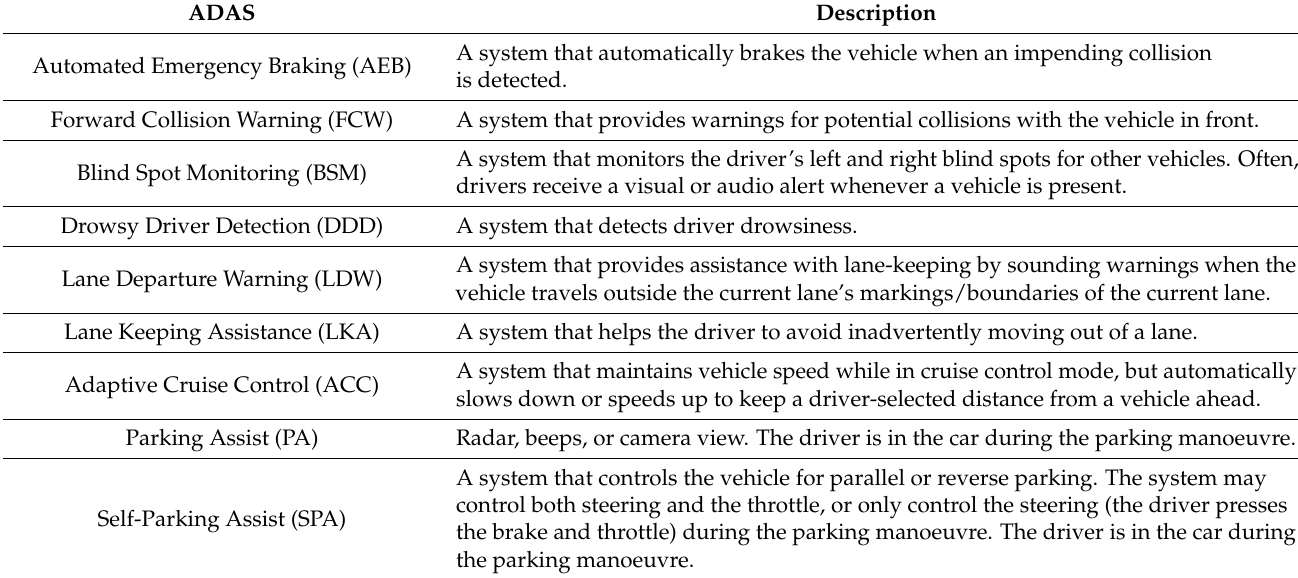
Table 3. ADAS descriptions given to the survey